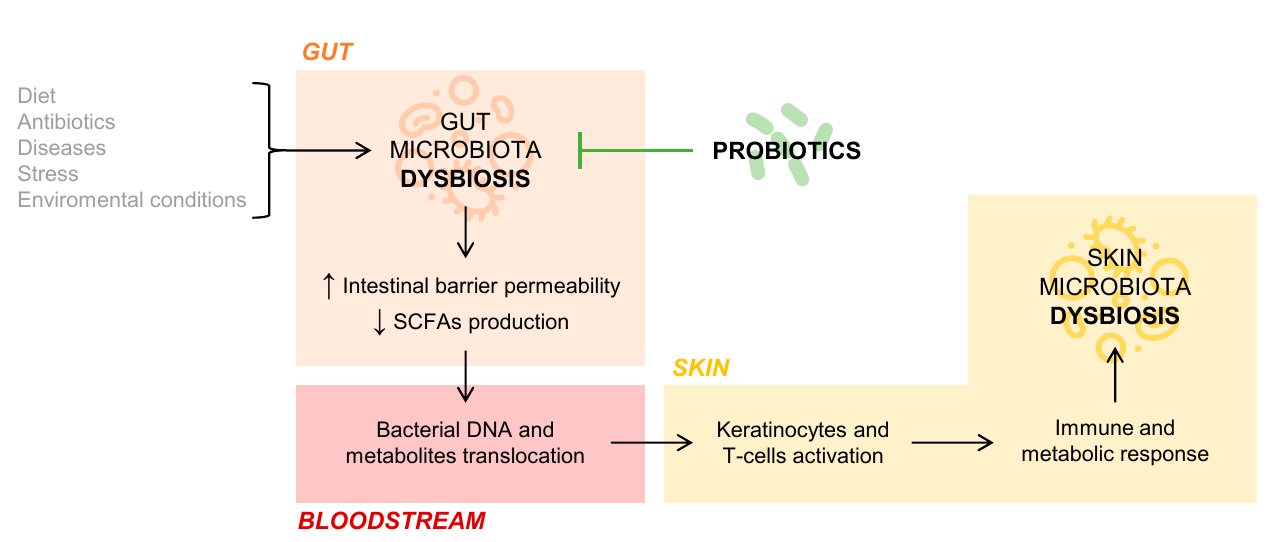
Figure 1. Gut and skin microbiota connection.